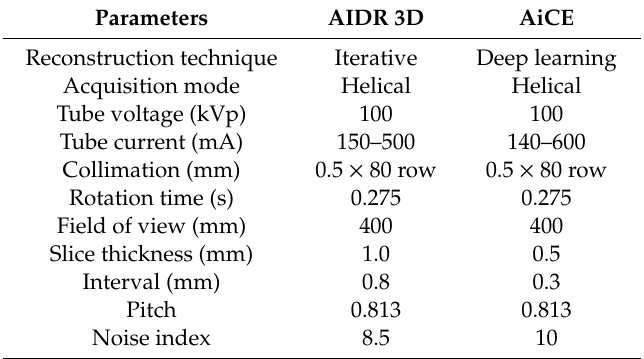
Table 1. In accordance with our standard CTPA protocol with the subtraction CT technique, all patients